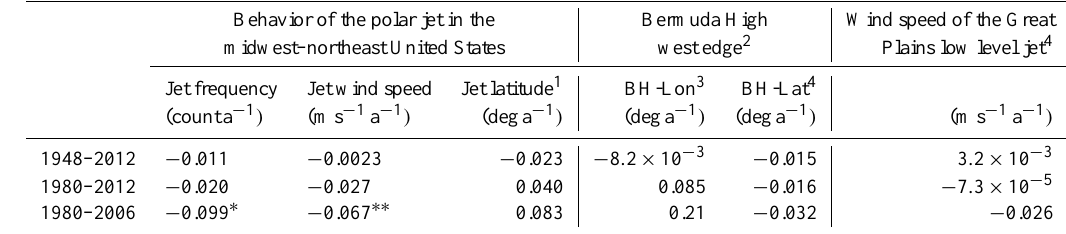
Table 2. Linear trends of the synoptic patterns examined in this study over the eastern United States for different time periods. Behavior of the polar jet in